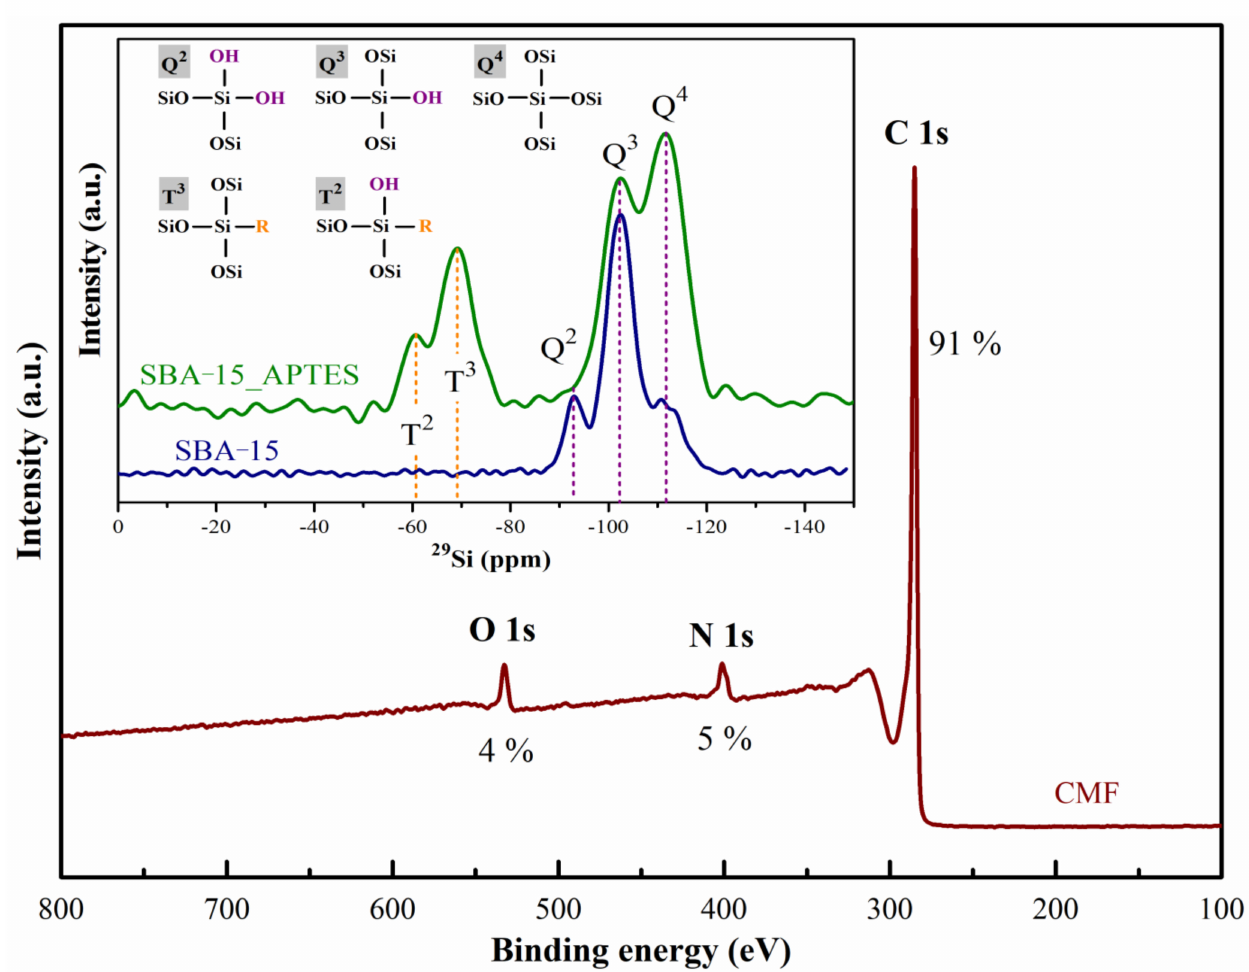
Figure 6. XPS for CMFs and 29 Si NMR for SBA-15 and SBA-15_APTES materials. By means of different characterization techniques, the textural, structural, and chemi- cal properties have been studied for the three materials: CMFs, SBA-15, and SBA-15_APTES. . h using different com- Now, we present the analysis of the variation in the value for ∆ ads binations of the temperature for the CO 2 isotherms. The point of reference will be the . h when nine isotherms were considered. Table 2 shows the selected curve obtained for ∆ ads arrangements, considering intervals of 5 K, 10 K, or 20 K, selecting towards lower or higher temperatures, within the studied interval (263 K to 303 K). The effect of the microporosity and chemical composition will be reflected in the results shown